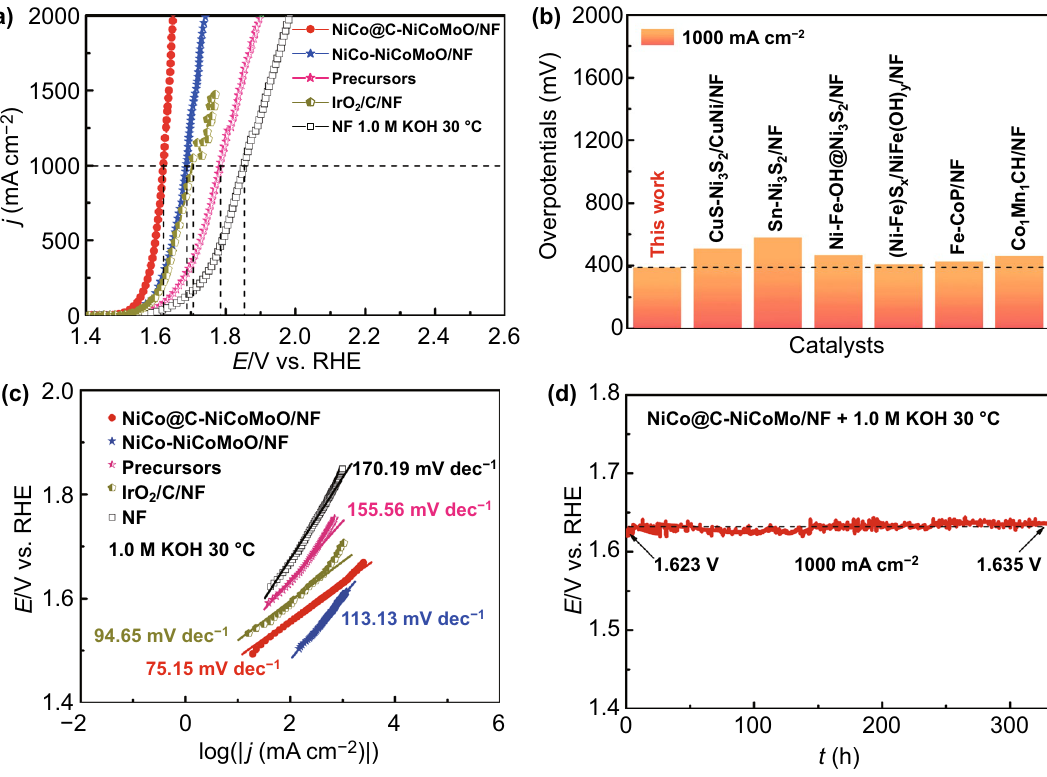
Fig. 5 a LSV curves of OER for investigated samples. b Comparisons of OER overpotentials in this work and reported catalysts [8, 47, 50, 53–56]. c Corresponding Tafel curves. d CP